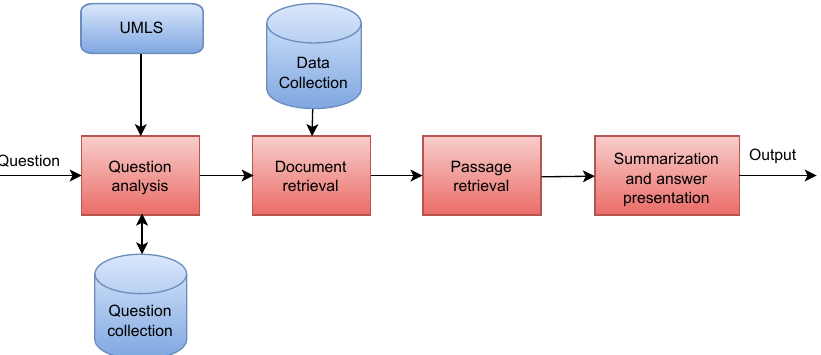
Figure 3. AskHermes’s system architecture